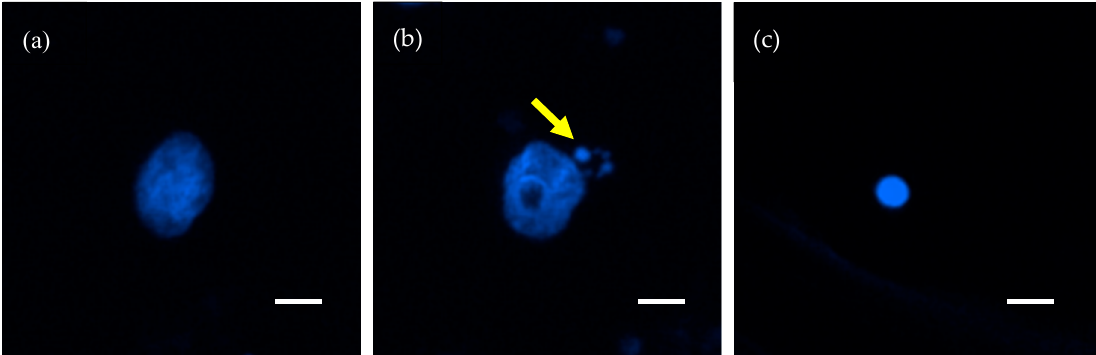
Figure 1. Representative images of nuclei stained with 4 ′ ,6-diamidino-2-phenylindole dihydrochloride. ( a ) Normal nucleus. ( b ) Nucleus harboring micronuclei (arrow). ( c ) Apoptosis. Scale bar = 10 μ m.